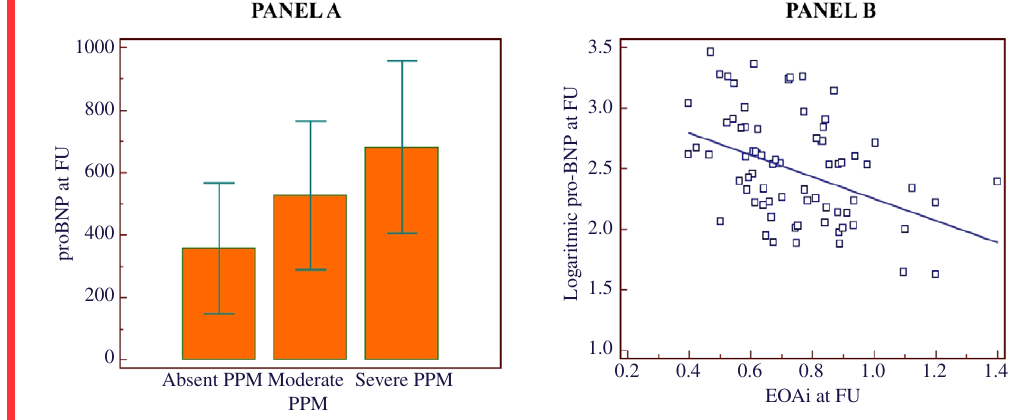
Figure. 12 Overall survival after mitral valve replacement in patients with non-significant, moderate and severe prosthesis-patient mismatch (PPM). (Reproduced and modified with permission from